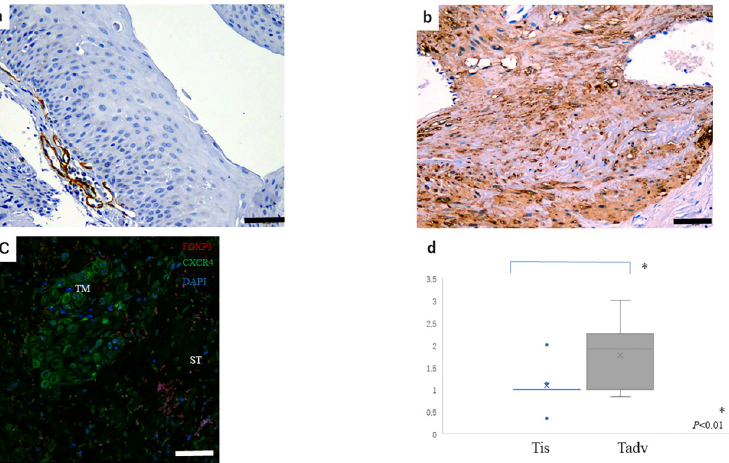
Fig 2. α -SMA expression for stromal scoring in tumor tissue. (a) Score: 1 (scale bar: 100 μ m). (b) Score: 3 (scale bar: 100 μ m). (c) Tumor (TM) and tumor stroma (ST) were examined by immunofluorescence using specific antibodies (FOXP3, CXCR4, and DAPI). Scale bar: 20 μ m. (d) A higher proportion of Tadv cancers expressed a high stromal score (score: 1.81) compared with Tis cancers (score: 1.12) ( P < 0.01).